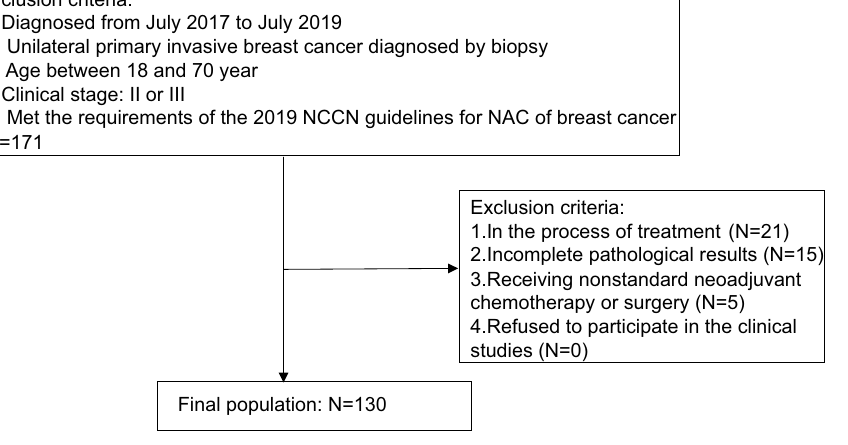
Figure 6. Eligibility, inclusion, and exclusion criteria of study